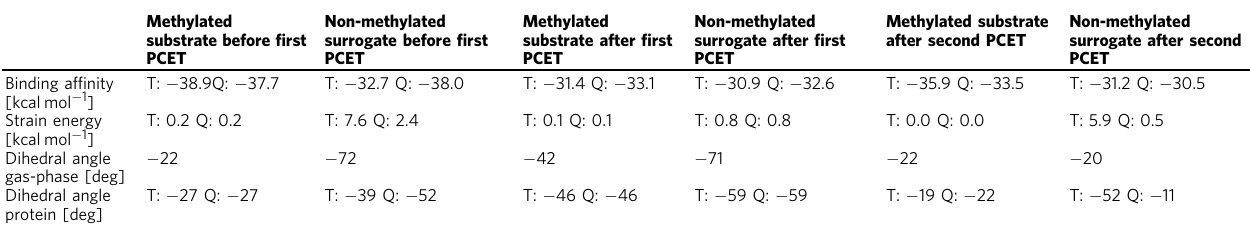
Table 1 Binding af fi nities, strain energies, and dihedral angles (C3 – C1 ″ – C1 ′ – C2 ′ ) for the substrates before and after the fi rst and second PCET steps Methylated Non-methylated substrate before fi rst surrogate before fi rst PCET PCET